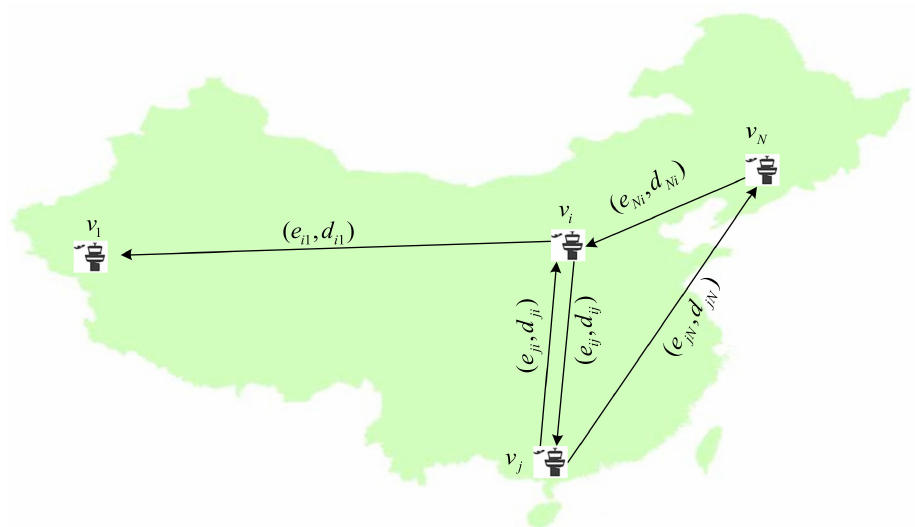
Figure 2. Direct causal network of airport delay propagation. The delay of airport v i is transmitted unidirectionally to airport v 1 , while there is a bidirectional delay propagation relationship between v i and v j